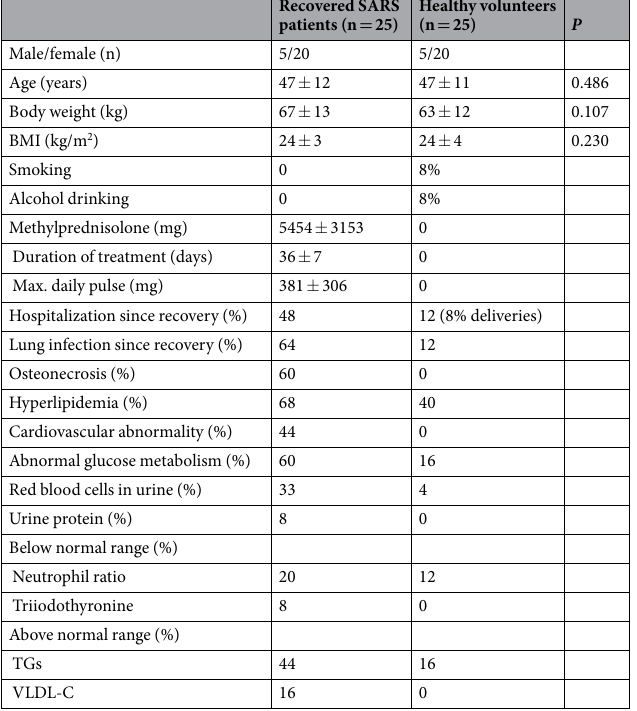
Table 1. General participant characteristics (means ± SD). SARS, severe acute respiratory syndrome; BMI, body mass index; TGs, triglycerides; VLDL-C, very low-density lipoprotein